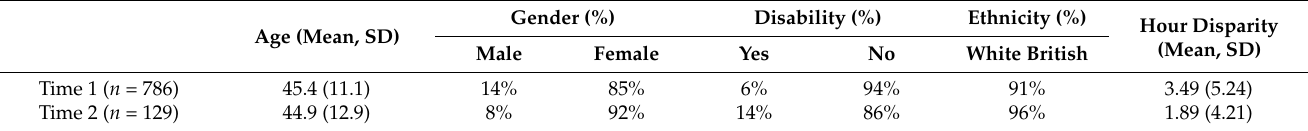
Table 1. Participant demographics pre- and